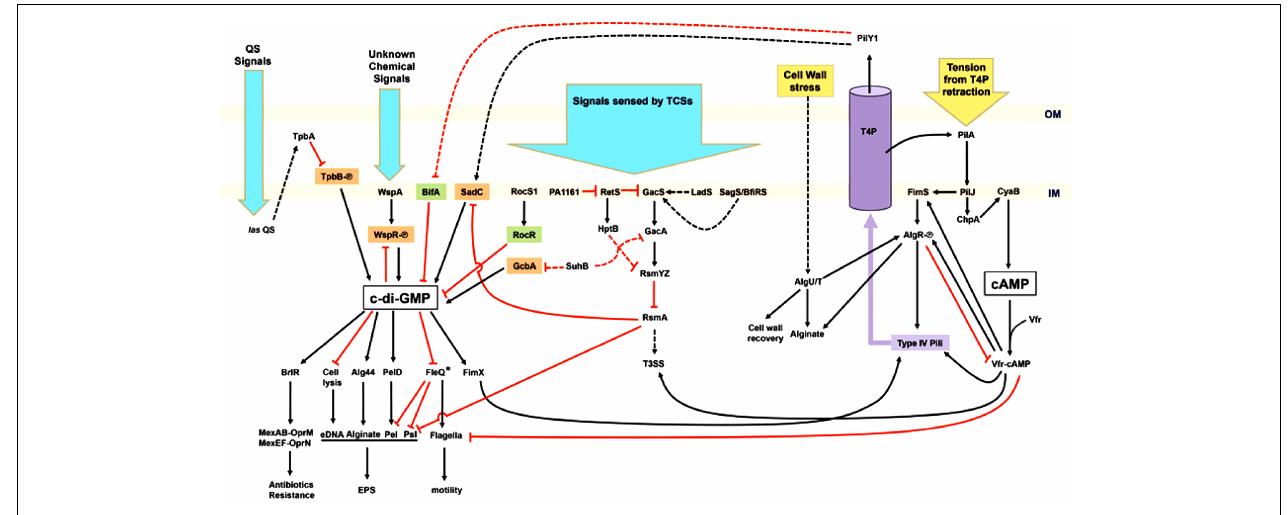
FIGURE 1 | Schematic illustration of the regulatory network of surface sensing in Pseudomonas aeruginosa . Upon bacterial attachment to the surface, chemical cues (blue arrows) such as quorum sensing (QS) signals and unknown chemical signals are received by various systems including QS, chemotaxis, and two-component systems (TCSs). Physical contacts (yellow arrows) causing bacterial cell wall stress and retraction of type IV pili (T4P) trigger responding pathways too. Cyclic-di-GMP, the key second messenger for the motile–sessile lifestyle switch, is generated by diguanylate cyclases (orange) and degraded by phosphodiesterases (green). The other second messenger, cAMP, is also involved in the regulation of T4P and flagella biosynthesis. The purple cylinder represents the assembled T4P across the outer membrane (OM) and inner membrane (IM). Phosphorylated proteins are labeled with . Activation events (black arrowheads) and inhibition events (red T-bars) may be mediated by transcriptional, translational, or post-translational regulatory mechanisms. Dashed arrows or T-bars represent indirect regulation or unknown pathways. Asterisk-labeled FleQ indicates that FleQ plays a dual role as an activator or a repressor in biofilm formation depending on c-di-GMP or ATP binding,